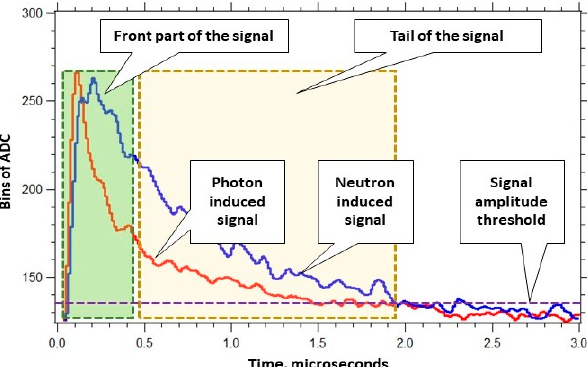
Figure 3. Cs 2 LiYCl 6 :Ce 3 + (CLYC) sensor: recorded neutron and gamma ray waveforms.